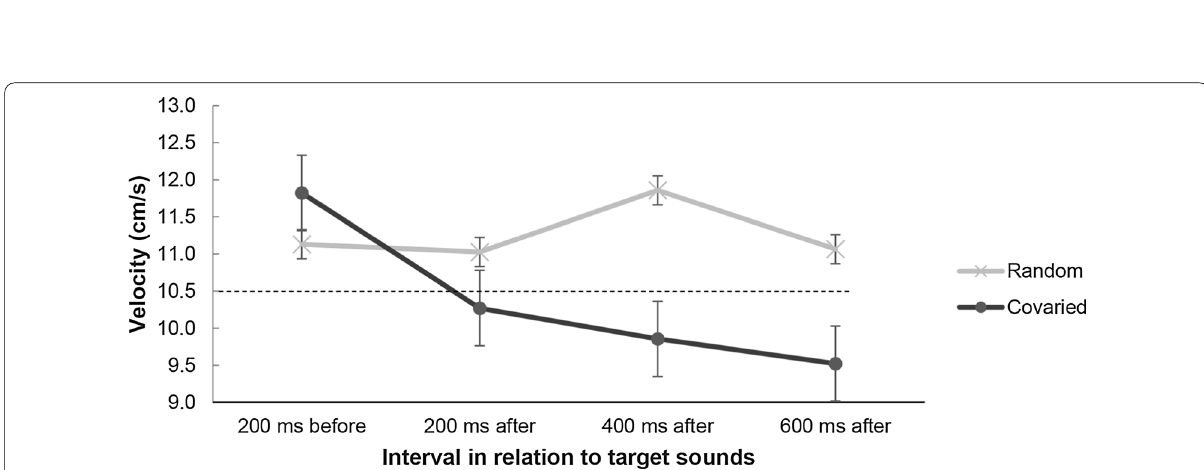
Fig. 11 Velocity analyses in Experiment 3. Baseline tracking velocity (200 ms before the occurrence of a target sound) was compared against 200 ms, 400 ms, and 600 ms after the sound onset. The dashed horizontal line represents the constant target velocity (10.5 cm/s). Covaried refers to dual-task trials in which sounds were coupled to the tracking path. Error bars show standard